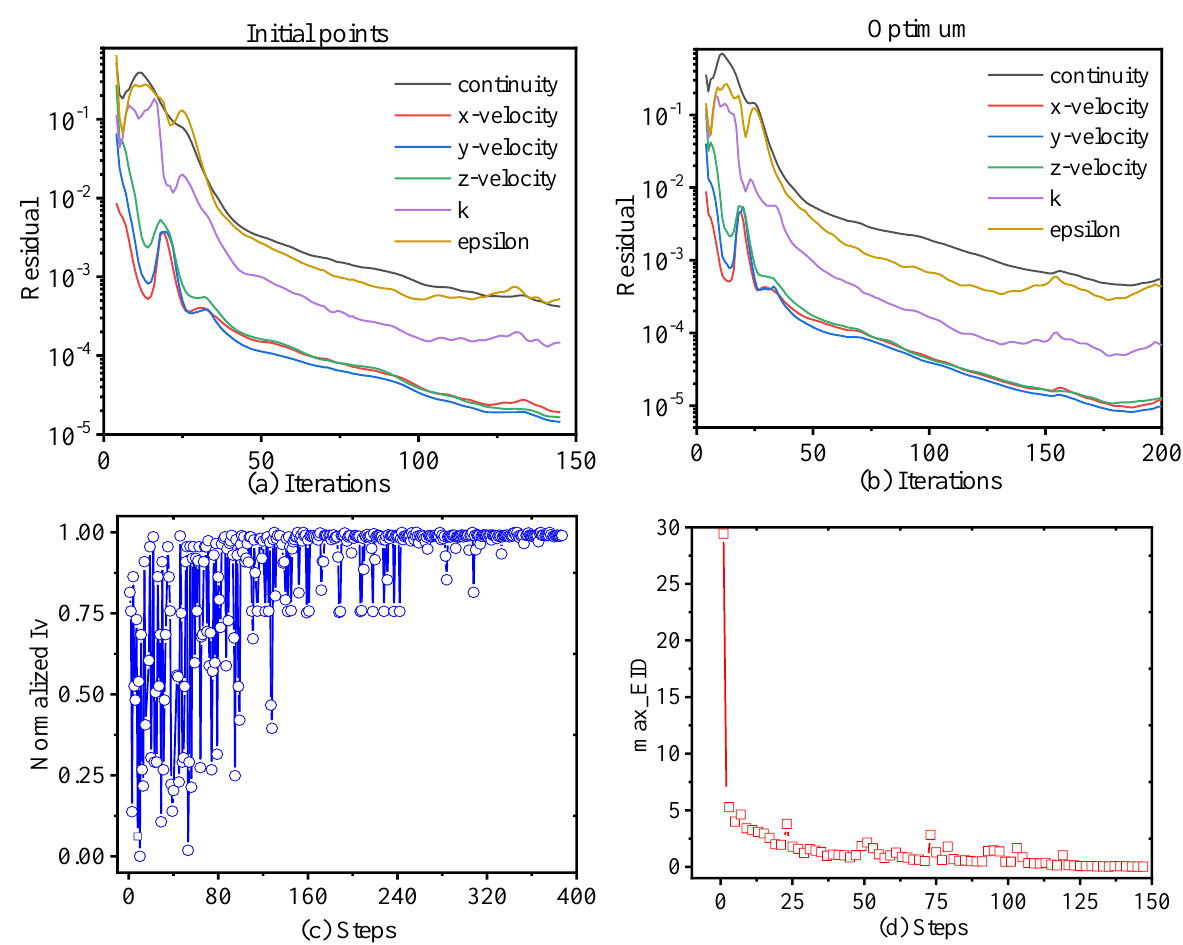
Figure 7. Search history of involved parameters in optimization.